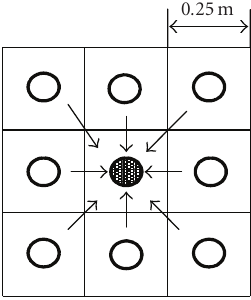
Figure 2: Heat transfer from FCs to cooled CPS channel.